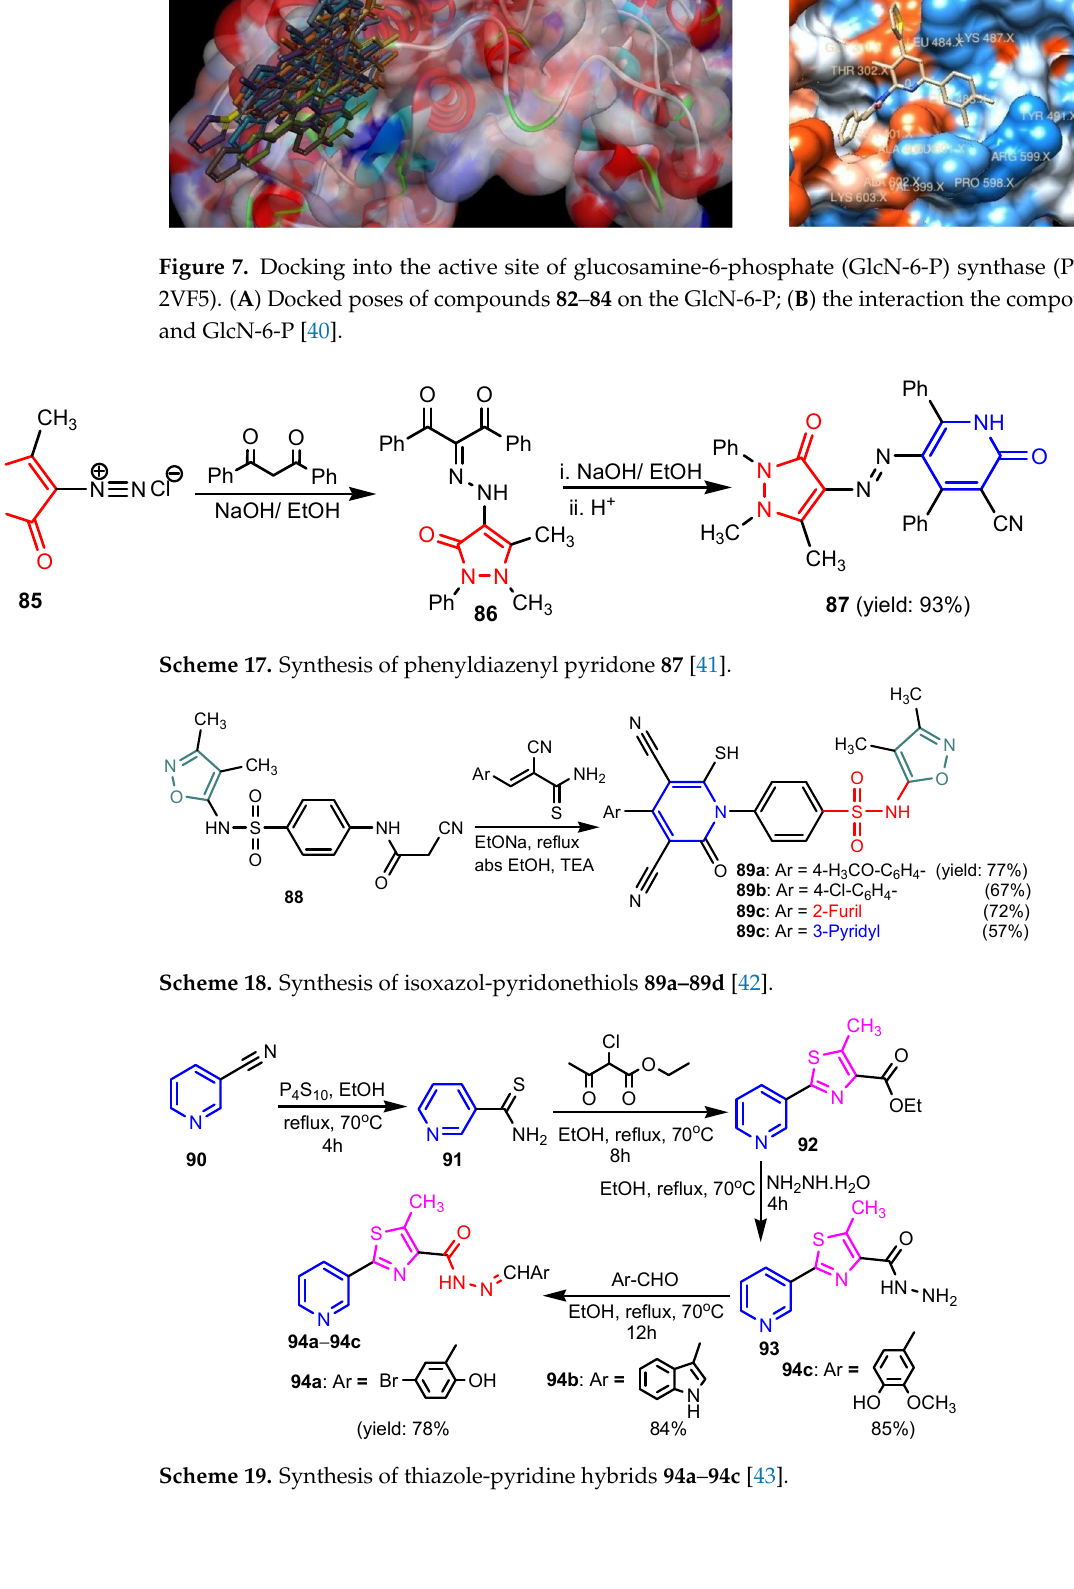
Figure 8. Structures of pyridine-benzothiazole hybrids 95 and 96 [44].